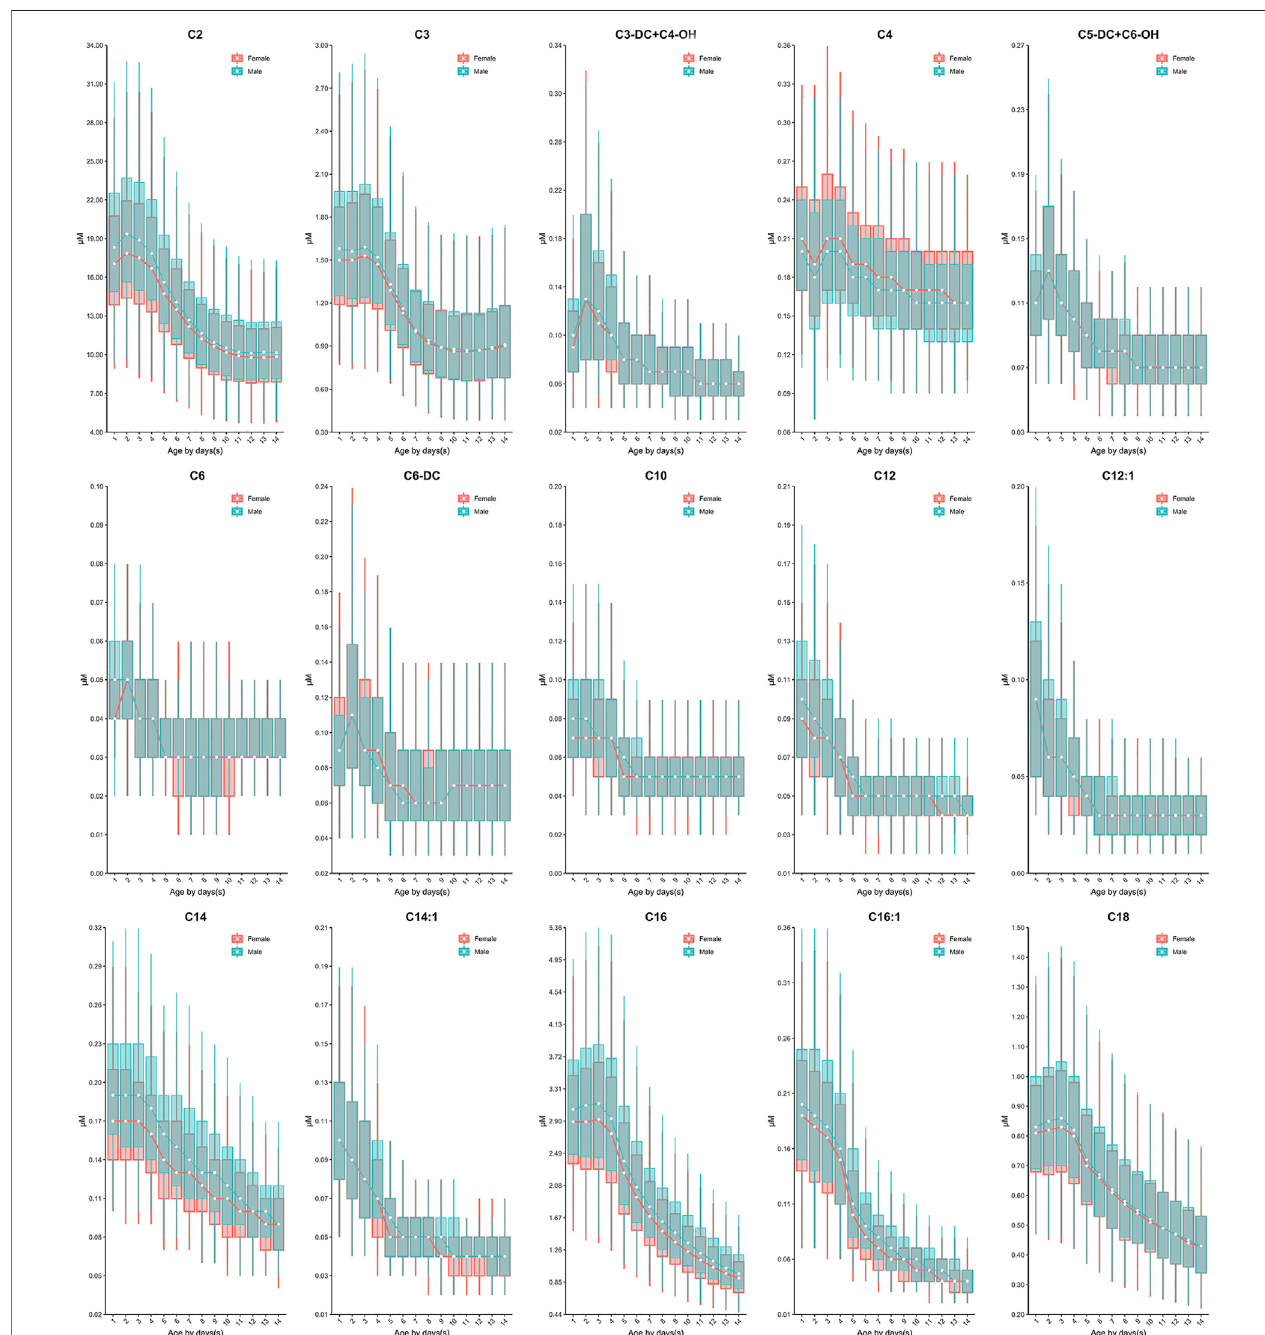
FIGURE3| ThedynamicchangeofC2,C3,C3-DC+C4-OH,C4,C5-DC+C6-OH,C6,C6-DC,C10,C12,C12:1,C14,C14:1,C16,C16:1andC18overageand sex. The data of male and female partitions are shown in green and red boxes with whiskers, respectively. The boxes extend from the 25 th to the 75 th percentile, with whiskersextendingtothe 2.5 th or 97.5 th percentile.The medians are shown aswhitecircles in thebody oftheboxes, and are linked with green(male) orred (female)line to shown the dynamic trends over age. Abbreviations are listed in the legend of Table 2